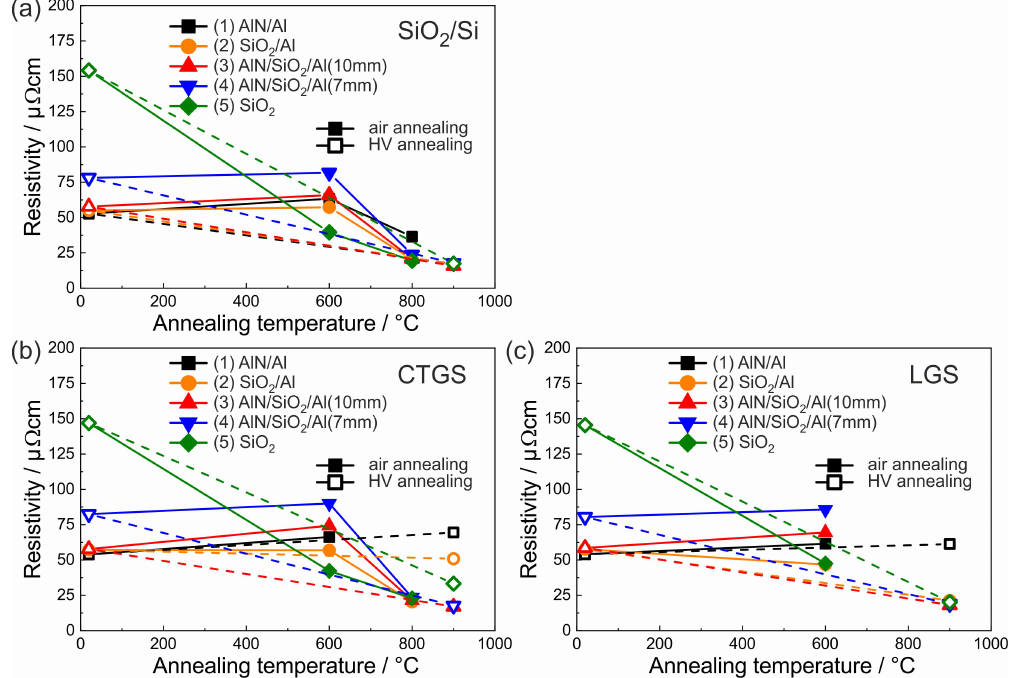
Figure 13. Electrical resistivity of the different film systems on ( a ) SiO 2 /Si, ( b ) CTGS, and ( c ) LGS substrates in the as-prepared state and after annealing. For SiO 2 /Si and CTGS, the values for the air annealed samples are shown up to 800 ◦ C and for LGS up to 600 ◦ C. The full symbols represent the annealing in air, the open symbols in HV. The straight lines visualize samples of the same